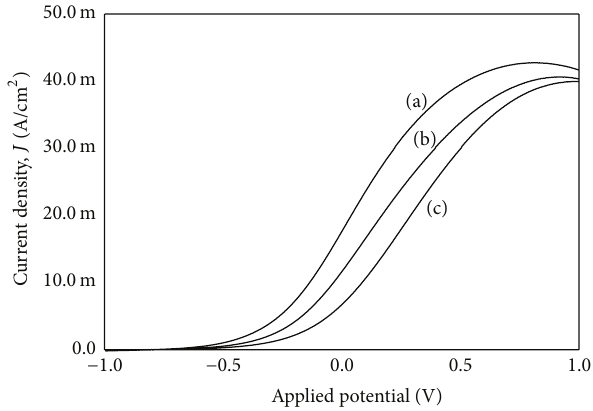
Figure 6: Current density-applied potential characteristics for (a) 1V, (b) 2 V, and (c) 3 V under ultraviolet illumination.